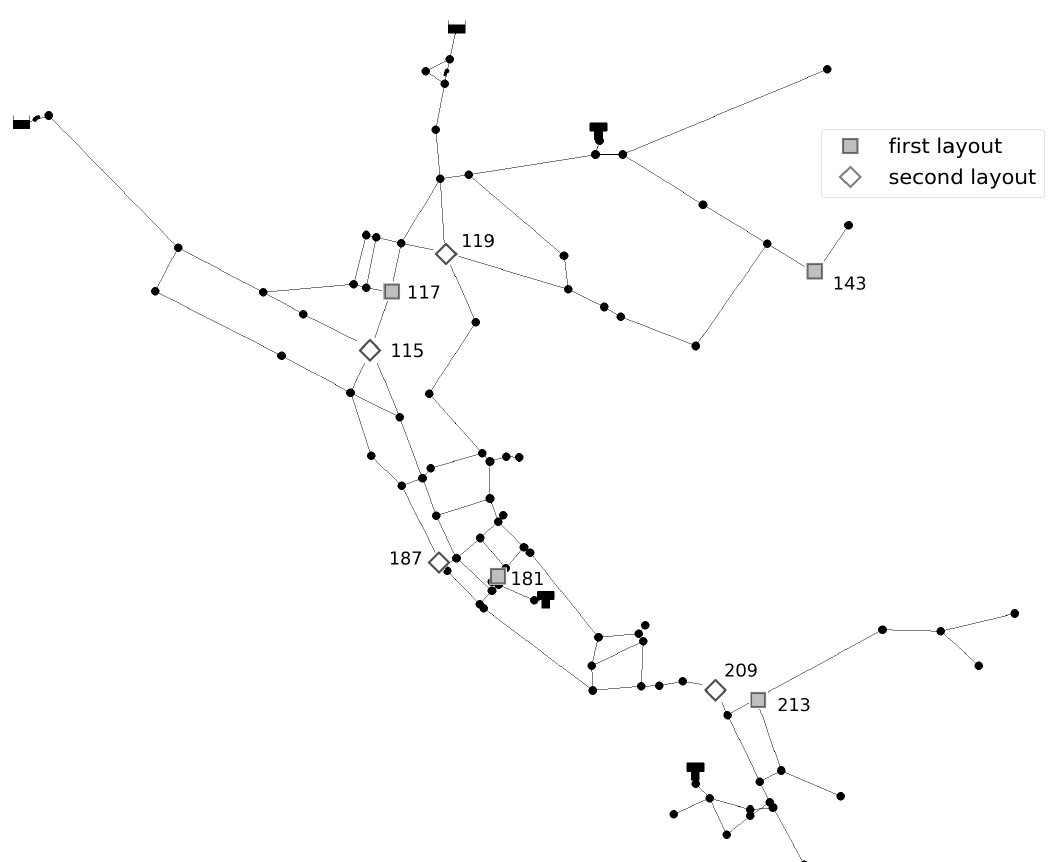
Figure 3. Net3 network with two sensor